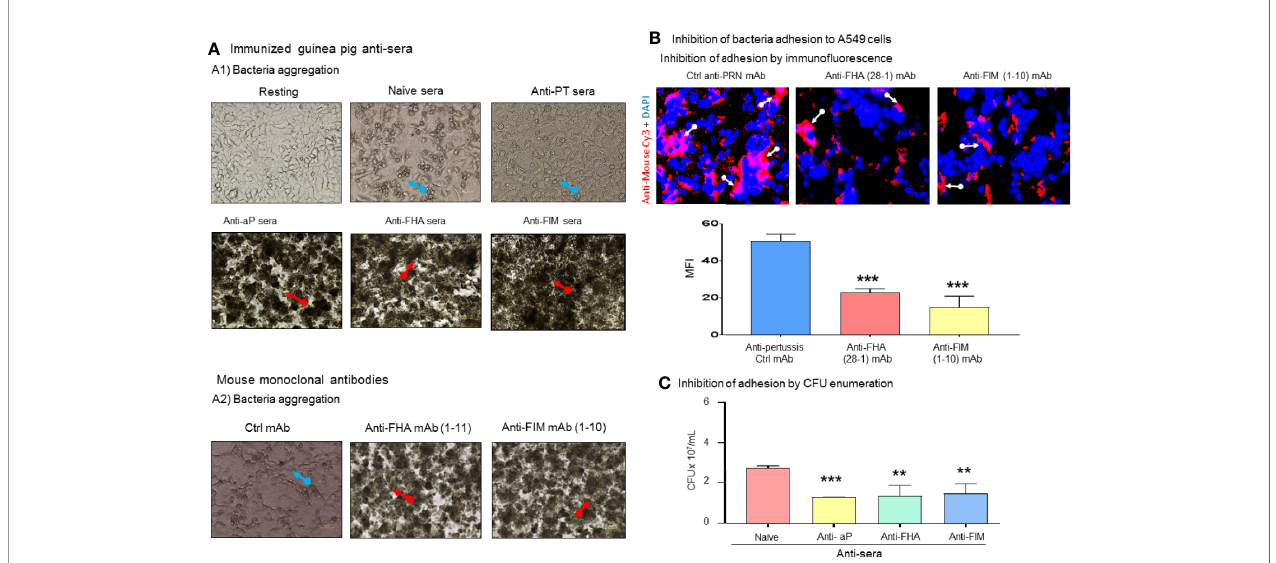
FIGURE 2 | Antibodies against B. pertussis key adhesins induced bacterial aggregation and inhibit adhesion. (A) Naïve control sera did not protect infected A549 cells which exhibited cluster formation and cell death (blue arrows) compared to con fl uent resting cells. Naïve sera did not induce bacteria aggregation (A1). Antisera containing antibodies against aP vaccine or single immunogens, FHA, and FIM, induced bacterial aggregation (red arrows) in 100% of tested sera as certain anti- FHA and anti-FIM mAbs induced bacterial aggregation (A2). (B) Speci fi c anti-pertussis antibodies inhibit bacterial adhesion. After 48 h of co-culture, anti-FIM and anti-FHA mAb signi fi cantly inhibited bacteria adhesion compared to control anti-PRN mAb (white arrow) to A549 cells which was con fi rmed using bacteria enumeration on Bordet-Gengou plate (C) . Mean±SEM. *** p <0.001 and ** p <0.01, n ≥ 3 experiments.